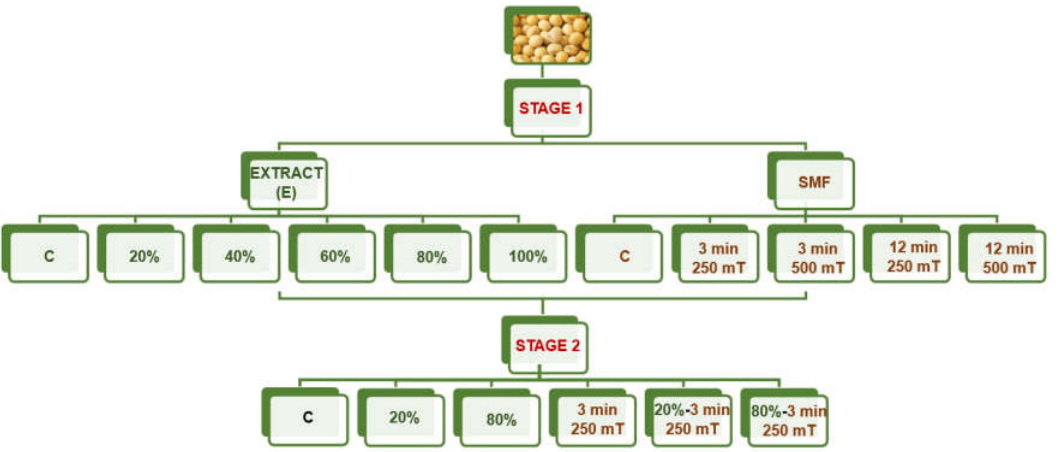
Figure 1. General scheme of performed experiments.